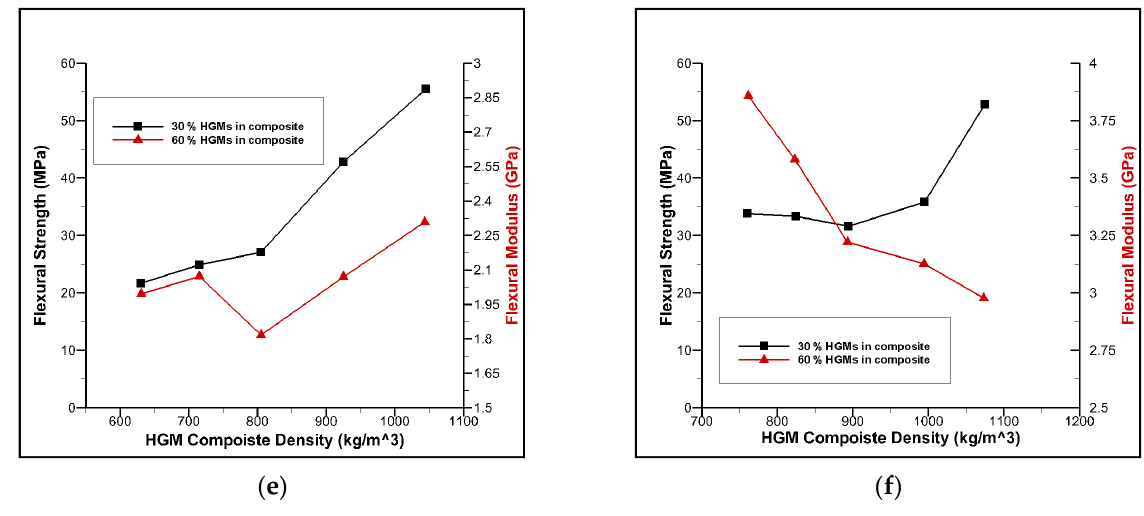
Figure 1. ( a ) Compressive stress-strain curve of epoxy matrix with HGMs. ( b ) Variation in compressive strength and modulus regarding the HGM composite density. ( c ) Tensile stress-strain curves of HGM composites. ( d ) Variation in tensile strength and modulus regarding the HGM composite density. ( e ) Variation in flexural strength and modulus with HGMs of 150 kg/m 3 density. ( f ) Variation in flexural strength and modulus with HGMs of 460 kg/m 3 density [25].